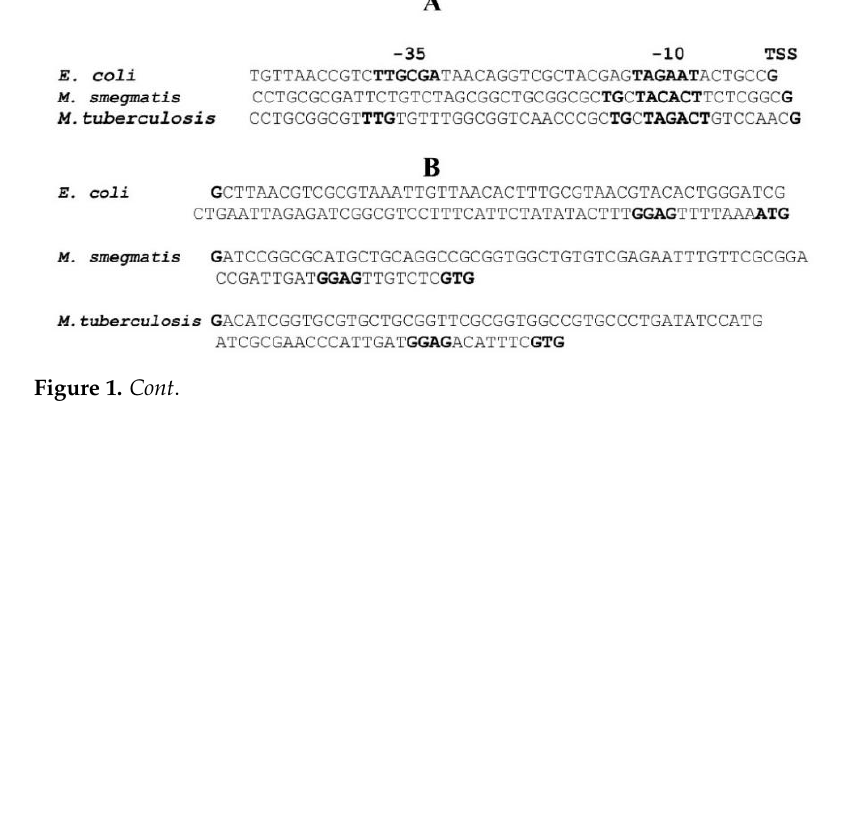
Figure 1. Regulatory elements in front of the rpsO coding region in E. coli , M. smegmatis, and M. tuberculosis. ( A , B ) Comparison of the core rpsO promoters ( A ) and 5 ′ UTRs ( B ). The TSS (transcrip- tion start site), −1 0, −3 5 promoter regions ( A ) as well as the initiator codon and the Shine – Dalgarno element ( B ) are in bold. ( C ) 5′ UTRs of E. coli , Msm, and Mtb rpsO mRNAs are able to form pseu- doknots (according to [37]); the most stable structures are shown as pairing probability arcs. ( D ) Presumable intrinsic transcription terminator of the Msm rpsO gene; complementary sequences forming a hairpin structure are underlined. It should be emphasized that the 5 ′ UTRs of E. coli rpsO as well as both mycobacterial rpsO 5′ UTRs are able to fold into pseudoknots (Figure 1C). The main difference is that in E. coli , the pseudoknot includes the beginning of the coding sequence, while in Msm and Mtb, it is likely formed upstream of the start codon, according to the McGenus algorithm [37]. In E. coli , the pseudoknot in the rpsO TIR is recognized by uS15 and serves as an autogenous operator, providing the S15-mediated ribosome entrapment in a non-produc- tive initiation complex [9 – 11,14]. It would be interesting to ascertain whether the myco- bacterial rpsO pseudoknots could act in a similar way. Finally, the Msm rpsO operon bears